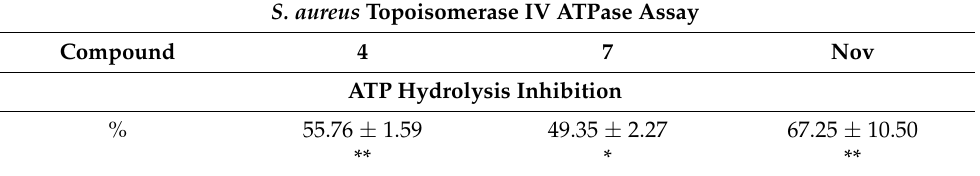
Table 2. ATPase activity of S. aureus topoisomerase IV treated with the tested compounds 4 and 7 (20 µM), demonstrated as a percentage of ATP hydrolysis inhibition compared to control (%) ± SEM from two independent experiments.